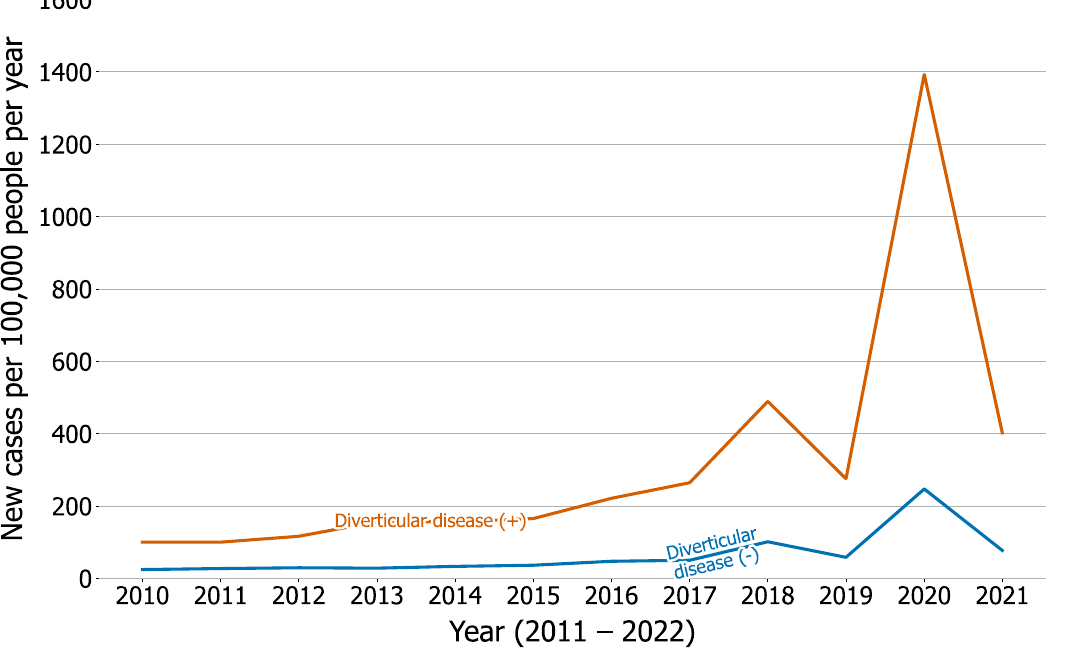
Figure 2. Yearly incidence rate of EOCRC (measured by new cases per 100,000 people per year) between 2010 and 2021 among young adults (age 20–49) with and without diverticular disease. 3.2. Increased Risk of EOCRC among Patients with Pre-Existing Diverticular Disease Compared to Propensity-Score-Matched Patients without Diverticular Disease Before propensity-score matching, the Diverticular disease (+) and Diverticular dis- ease (-) cohorts differed significantly with respect to many of the potential confounders, including demographics (age, gender, race, ethnicity), adverse socioeconomic determi- nants of health and lifestyles, comorbidities, and medications that are relevant to both diverticular disease and EOCRC, as demonstrated by the 2016 population. Compared to the Diverticular disease (-) cohort, the Diverticular disease (+) cohort was older, comprised more male, Hispanic and White patients, had higher proportions of patients who had problems related to lifestyle, were users of tobacco, alcohol drinkers, NSAIDs or aspirin, and had higher prevalence of obesity and overweight (Table 1). After propensity-score matching, the Diverticular disease (+) and Diverticular disease (-) cohorts were balanced, demonstrating that effects of potential confounders were minimized by propensity-score matching (Table 1). Similar characteristics for other study populations were observed.